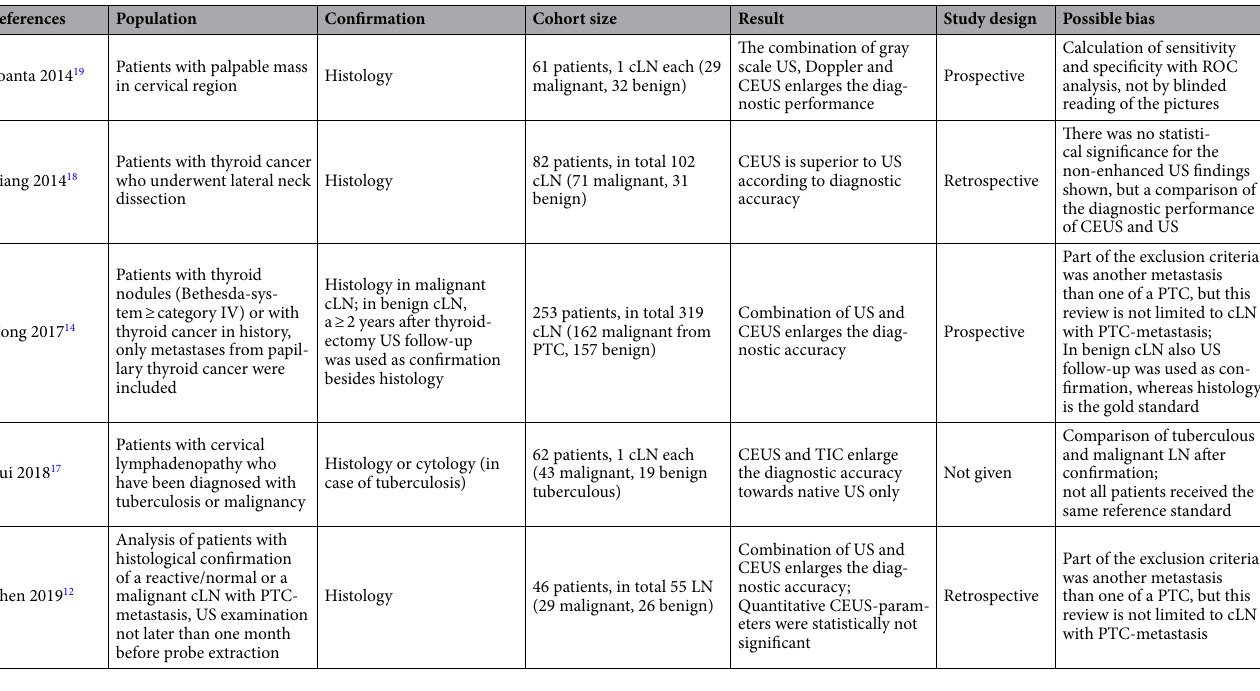
Table 2. Overview and synopsis of the included studies.